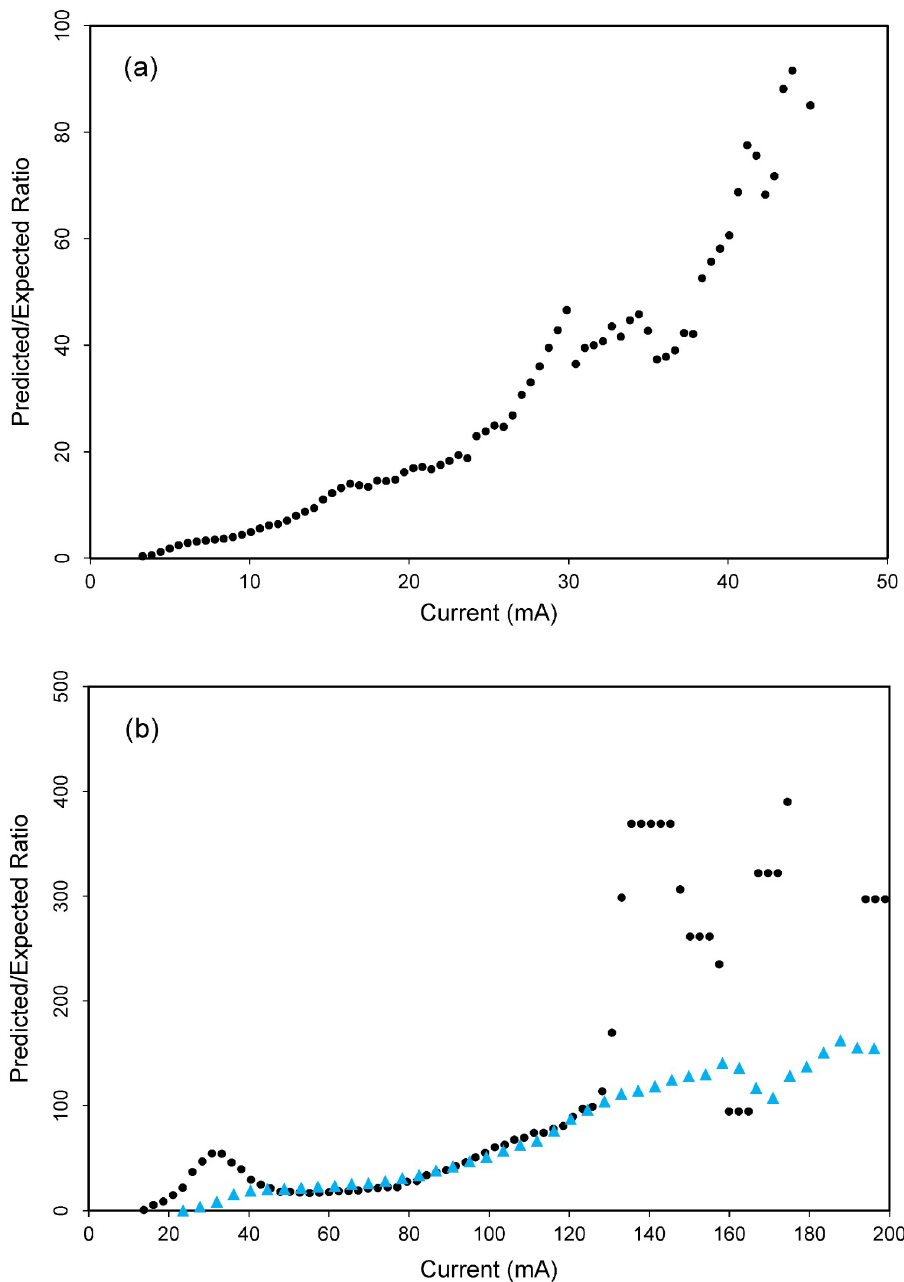
Fig 3. Continuous predicted/expected plots of electrical current models for California condors in (a) central California and (b) southern California, USA. Blue triangles in (b) represent the predicted/expected plot when Hopper Mountain National Wildlife Refuge and the Tehachapi Mountains were added as additional ground nodes in the electrical